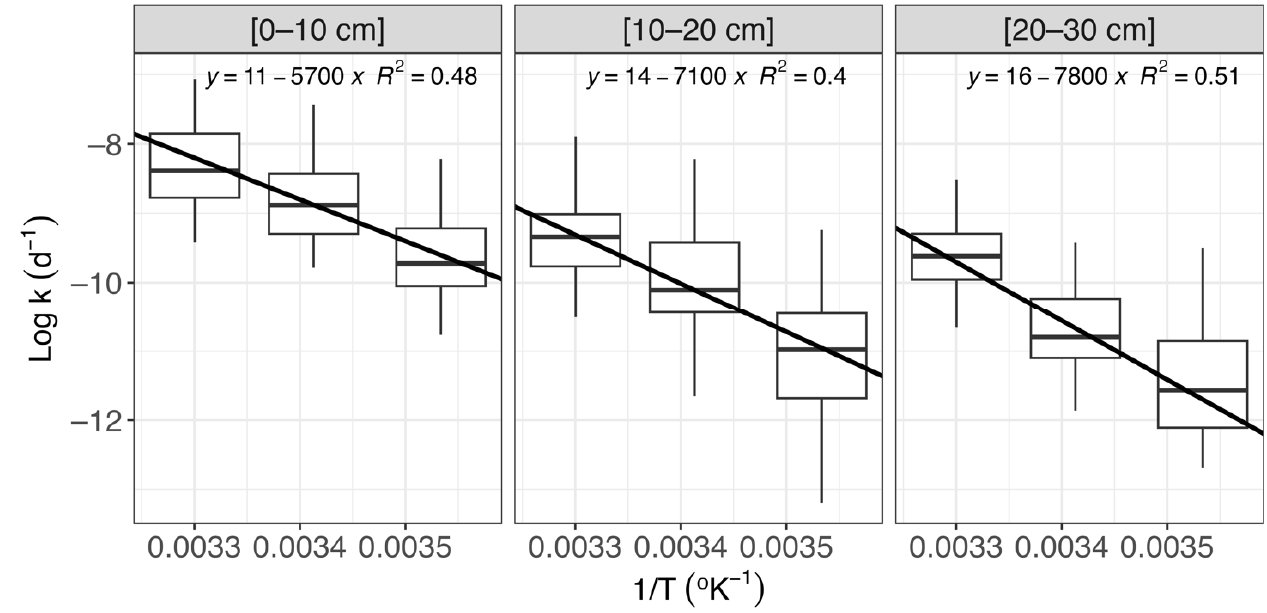
Figure 5. Experimental data fitted to the Arrhenius equation ( p -value < 0.001).